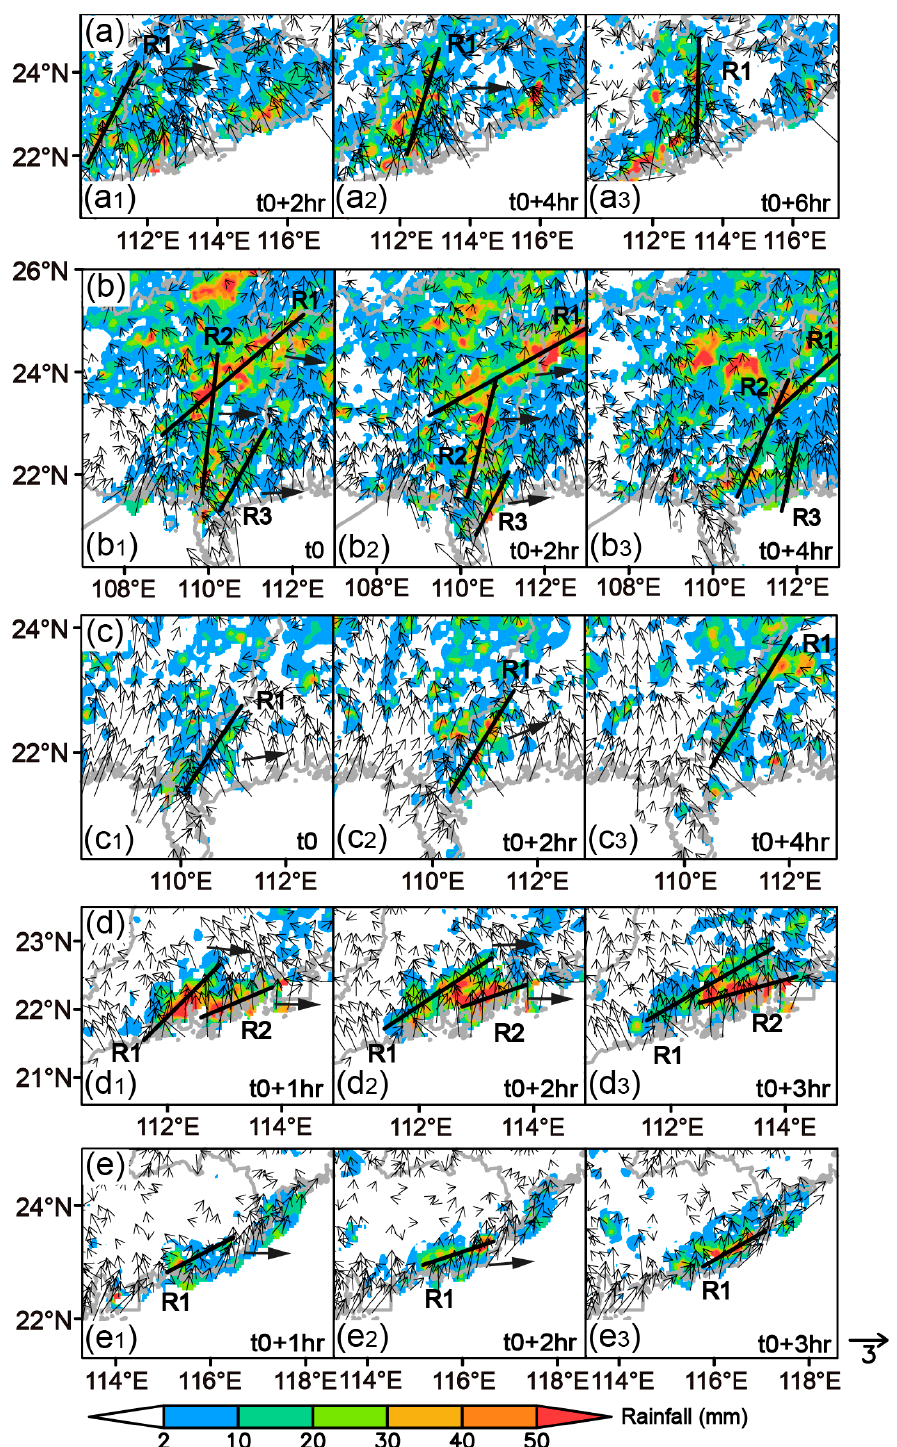
Figure 12. Evolution of composite cumulative rainfall distributions (color-shaded; units: mm) and near-surface wind vectors (units: m s − 1 ) under the vertical wind profile of WP1-1 in the SWLLJ situation. The lines (“R1,” “R2,” and “R3”) and arrows indicate rainfall belts and their approximate motion directions, respectively. “t0” and “t0 + x h” indicate the initial time of rainfall and “x” hours after. “ a 1 – a 3 ” to “ e 1 – e 3 ” ( a – e ) show the evolution of the composite cumulative rainfall distributions and near-surface wind vectors near the coastal areas of Guangdong Province, Guangxi Province, the boundary between Guangxi and Guangdong provinces, and west and east Guangdong